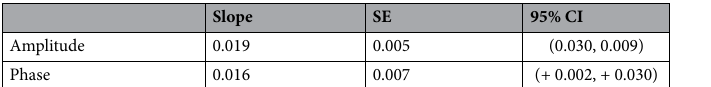
Table 1. Results of the linear mixed model fits of change in amplitude of accommodative response with repetition number for the preliminary trials. Slope estimates are shown along with their corresponding standard errors (SE) and the 95% confidence intervals (CI). The units of the slopes are D per repetition for amplitude and s per repetition for